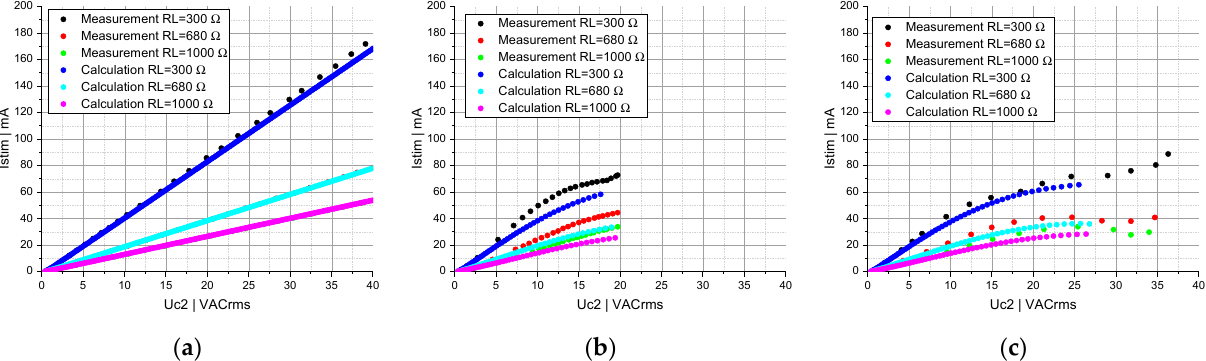
Figure 7. Stimulation current Istim as a function of the induced voltage Uc2 for a circuit topology of two series-connected: ( a ) linear capacitors; ( b ) linear and nonlinear capacitors; ( c ) nonlinear capacitors. The measurements (black, red, green) and calculations (blue, cyan, magenta) were performed for R L = 300 Ω , 680 Ω and 1000 Ω , respectively.